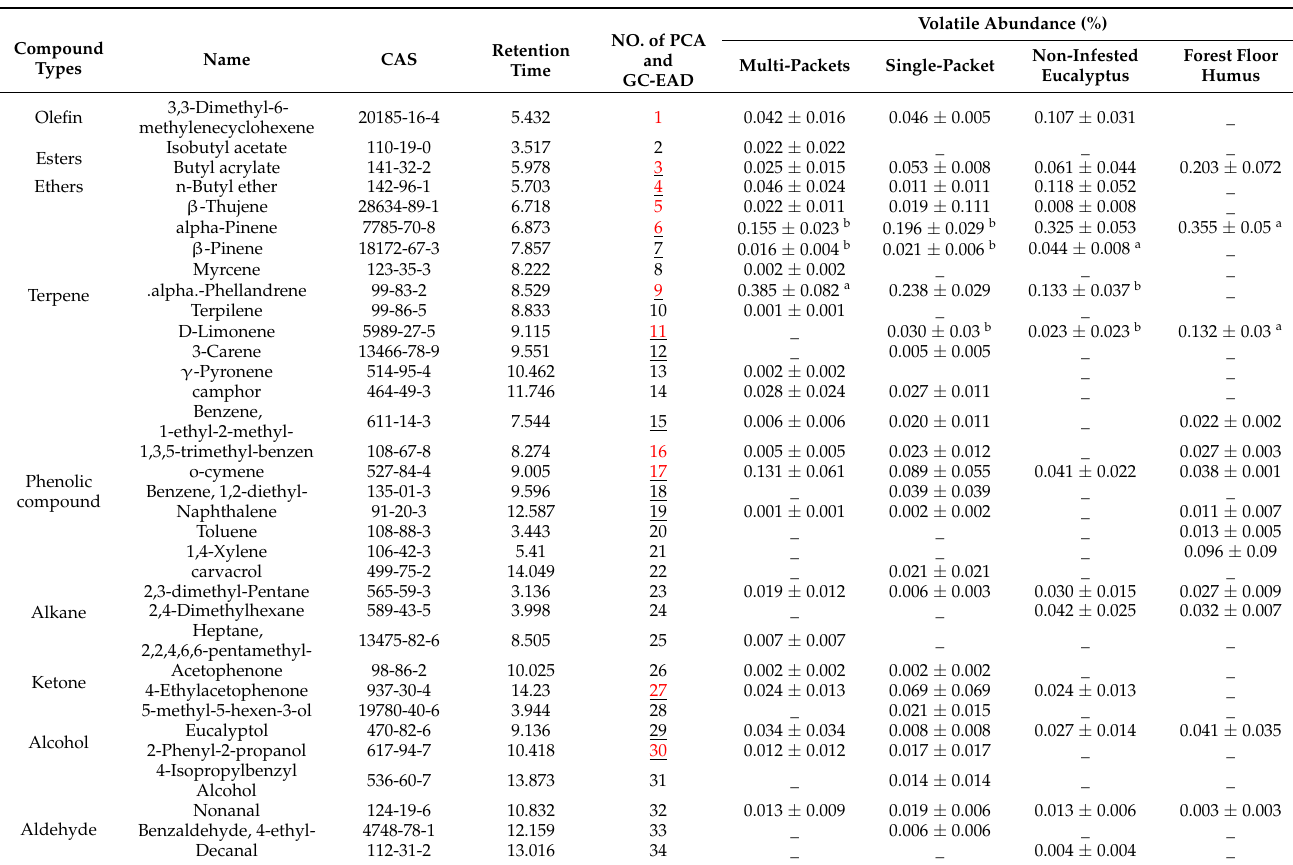
Table 1. VOCs identified by dynamic headspace adsorption of the eucalyptus trunk (non-infested, single packet, and multiple packets) and forest floor